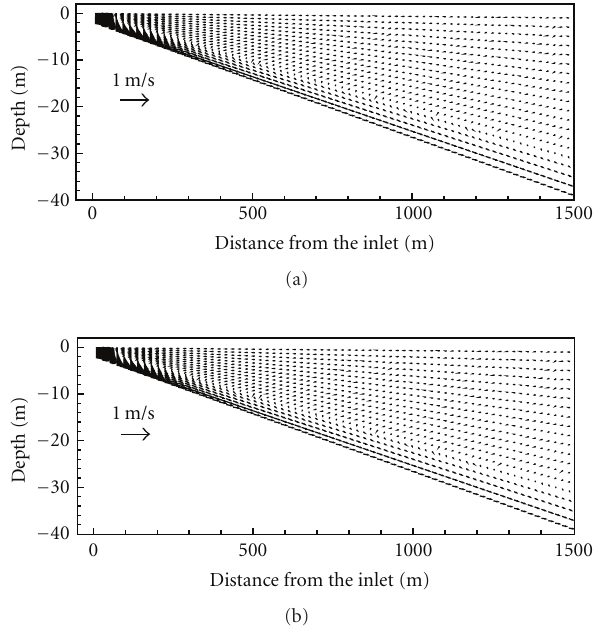
Figure 5: Simulated Velocity Field (a) the results of Bournet et al. [29] and (b) the present